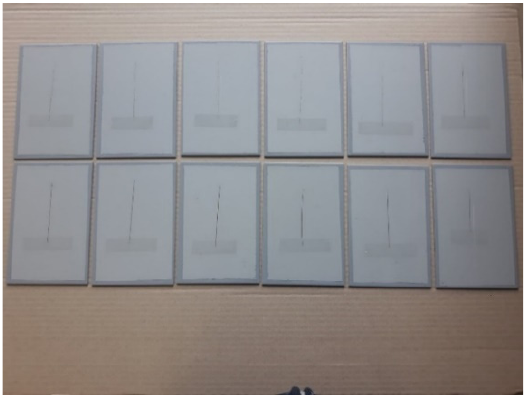
Figure 4. Prepared specimens before being placed in the salt-spray test chamber.